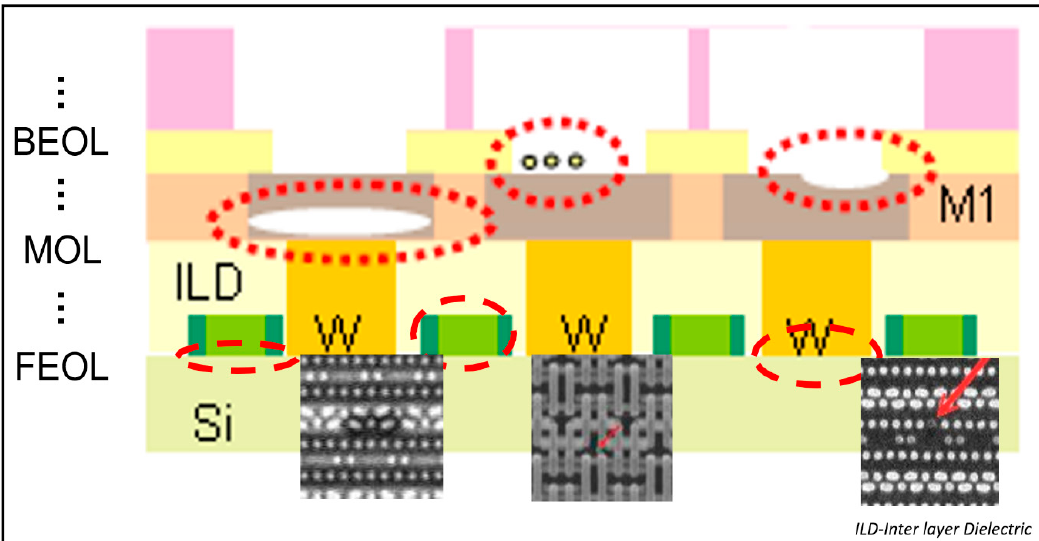
Figure 14. Defect detection with die to die/chip to chip.